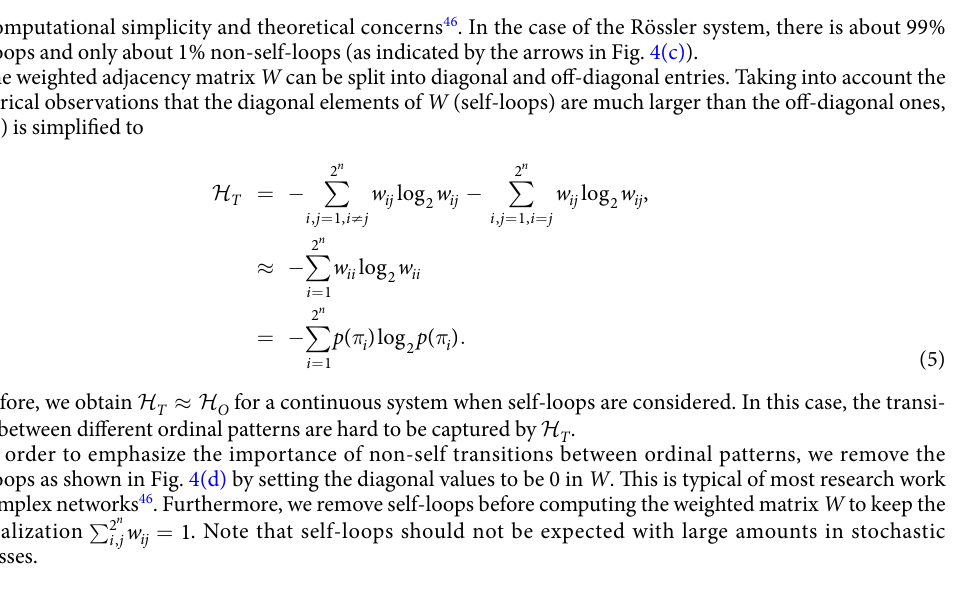
The histogram of order patterns (Fig. 5(c)) discovers that π 4 are forbidden patterns of the system, which yields